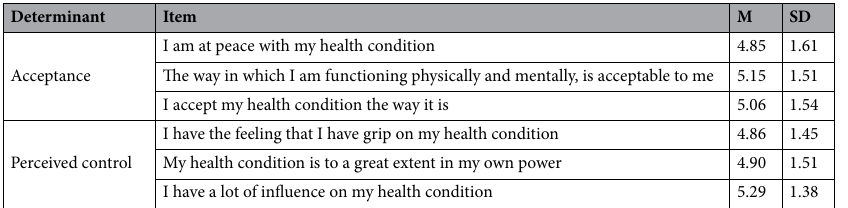
Table 1. Items of the Bloem & Stalpers questionnaire.